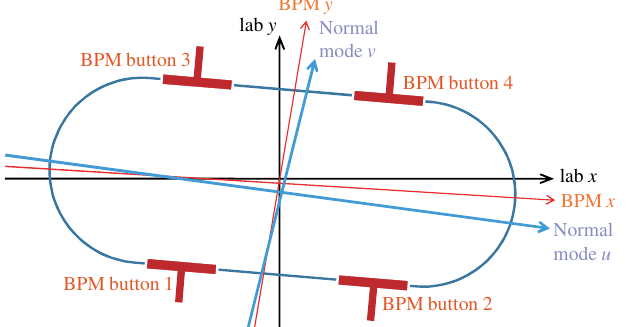
FIG. 1. Coordinate systems in a BPM. The laboratory coordi- nate system is defined with respect to the survey positions. BPM alignment and electronics errors mean that the coordinates returned by the BPM are with respect to the ‘‘BPM axes’’ which are not perfectly aligned with the laboratory system. Coupling means that resonant excitation of the transverse modes leads to motion along axes different from the laboratory or BPM axes. The four BPM buttons are labeled according to the convention used in